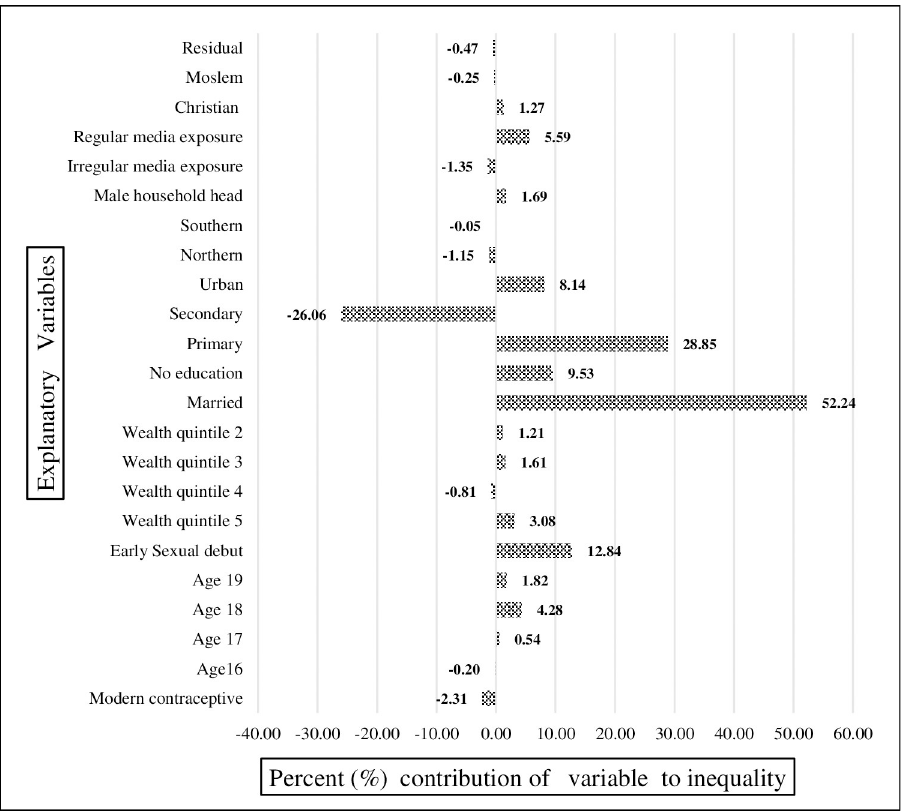
Fig 6. Decomposition of the concentration index for year 2004. Constructed by authors from MDHS 2004, 2010,